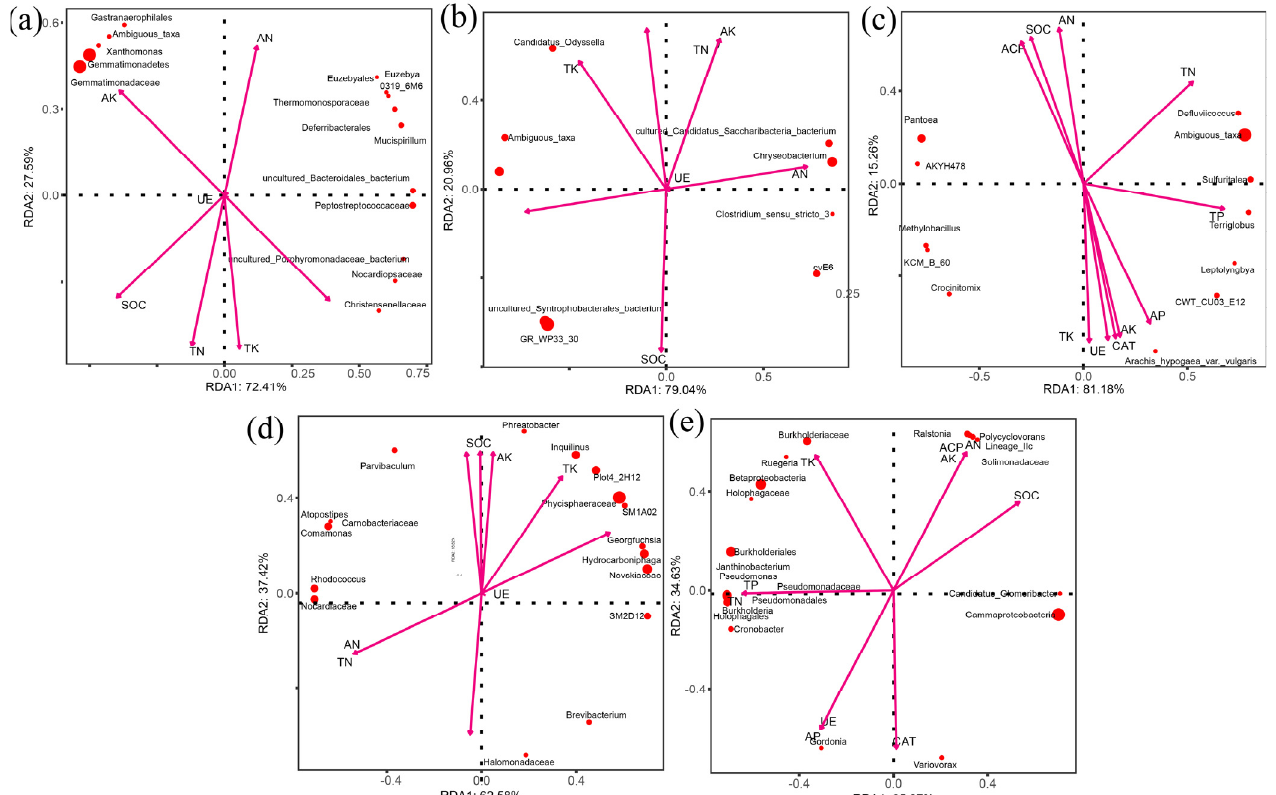
Figure 10. Redundancy analysis (RDA) of topsoil of bacterial communities under different litter mulching treatments and environmental characteristics. Arrows indicate environmental characteristics. The values of axes 1 and 2 are the percentages explained by the corresponding axis. ( a ) control, ( b ) leaf, ( c ) branch, ( d ) pericarp, ( e ) seed.